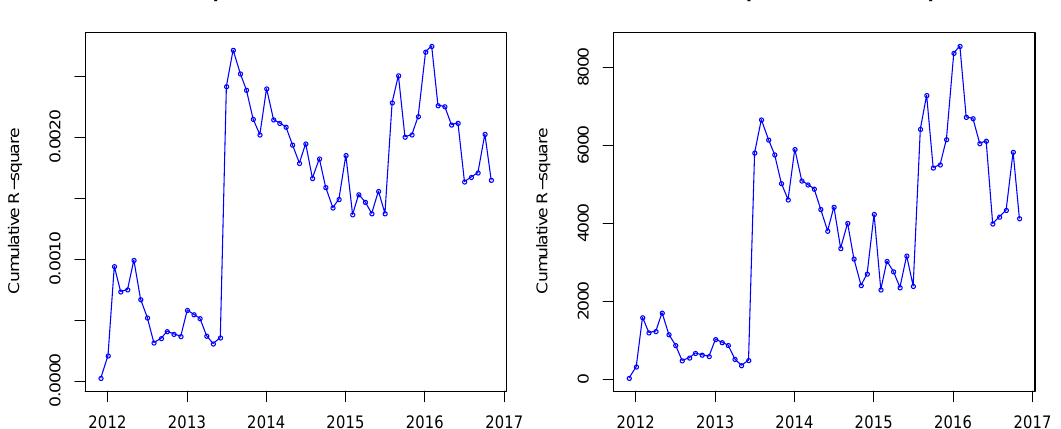
Figure 5. Cumulative squared predictive errors, CSPE, of S&P 500 monthly forecasted prices ( right ) and returns ( left ) from December 2011 to November